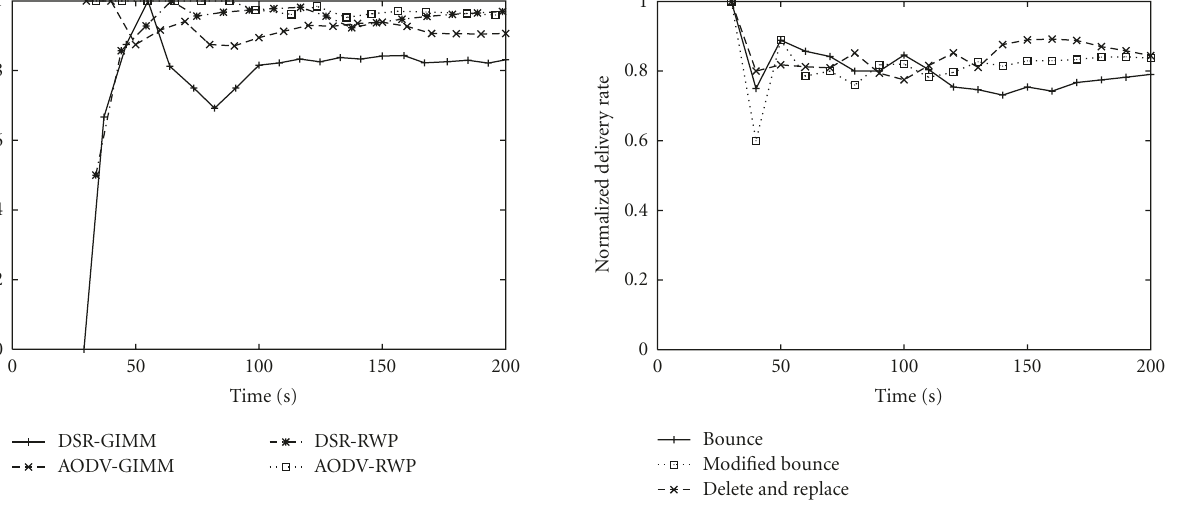
Figure 14: Delivery rate of the AODV and the DSR under the im- pact of mobility. Figure 15: The impact of the chosen border rule on AODV perfor-